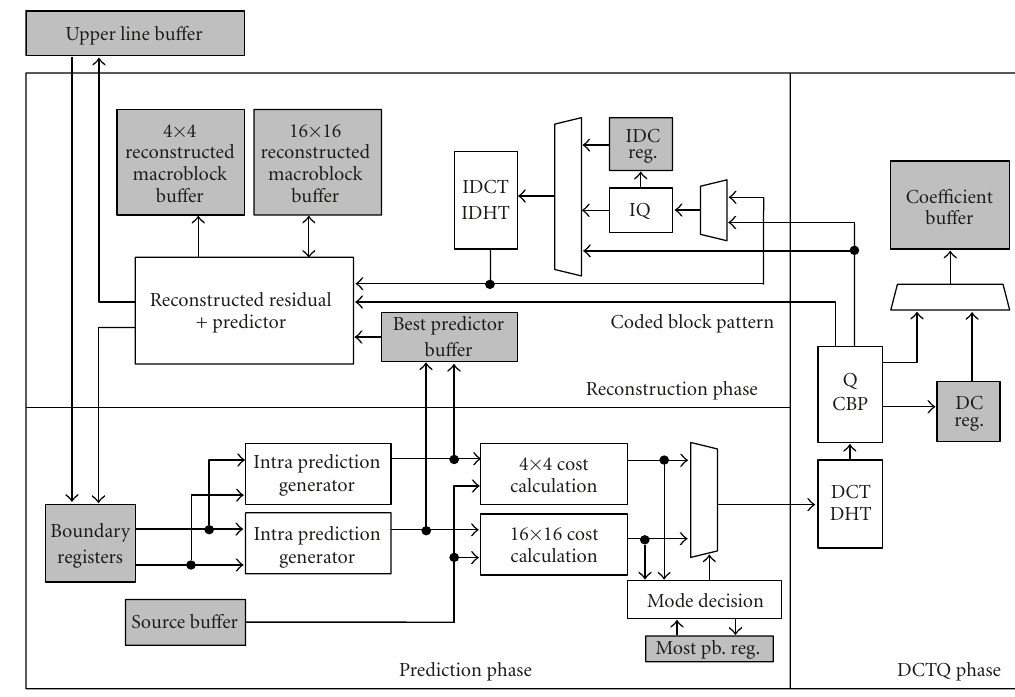
Figure 9: Block diagram of hardware implementation. Table 8: Execution time